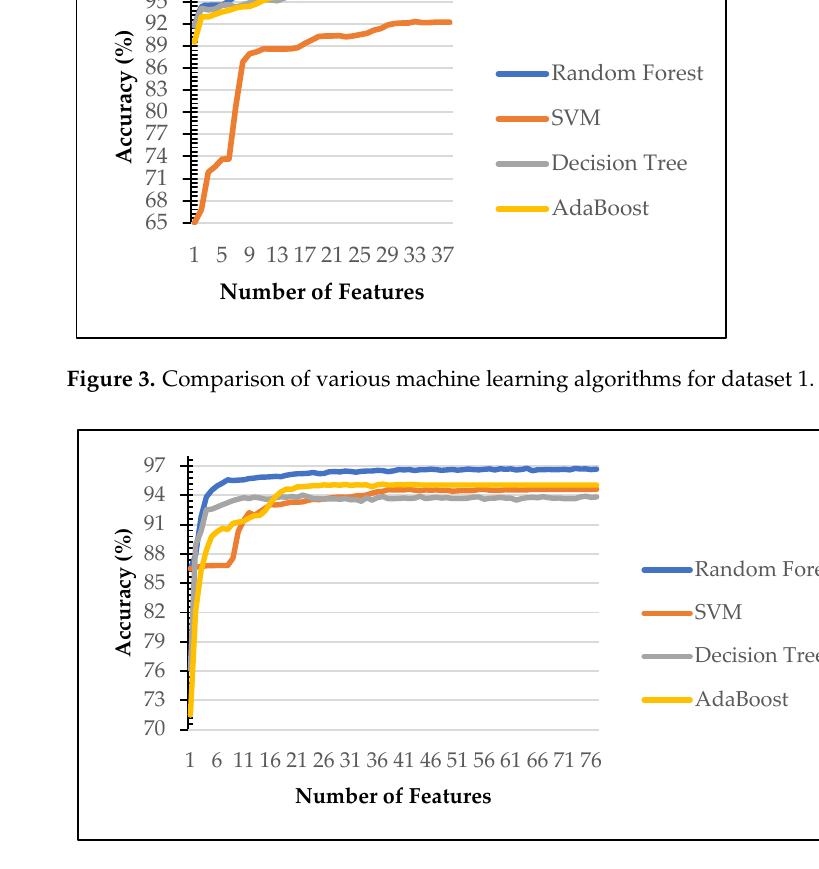
Figure 4. Comparison of various machine learning algorithms for dataset 2.